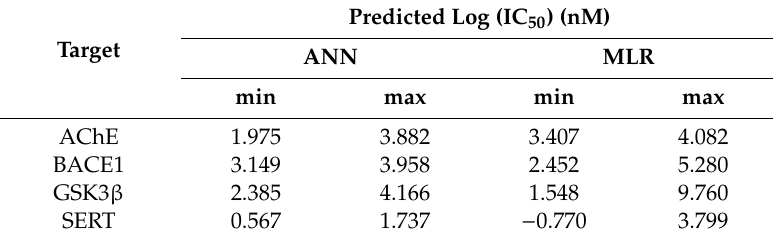
Table 2. The range of the predicted log (IC 50 ) of the selected compounds for all target proteins.